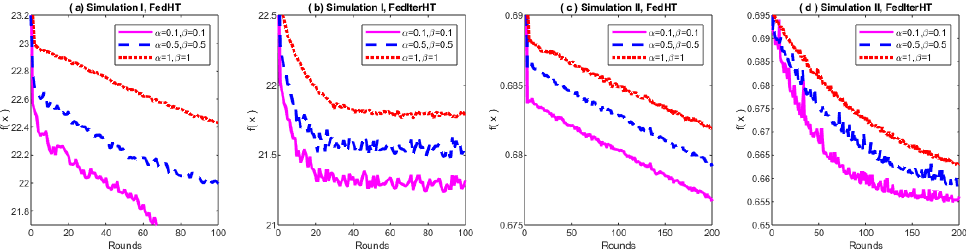
Figure 2. The objective function value vs. communication rounds for regression ( a , b ) and classifica- tion ( c , d ), and for Fed-HT ( a , c ) and FedIter-HT ( b , d ) with varying degrees of non-IID